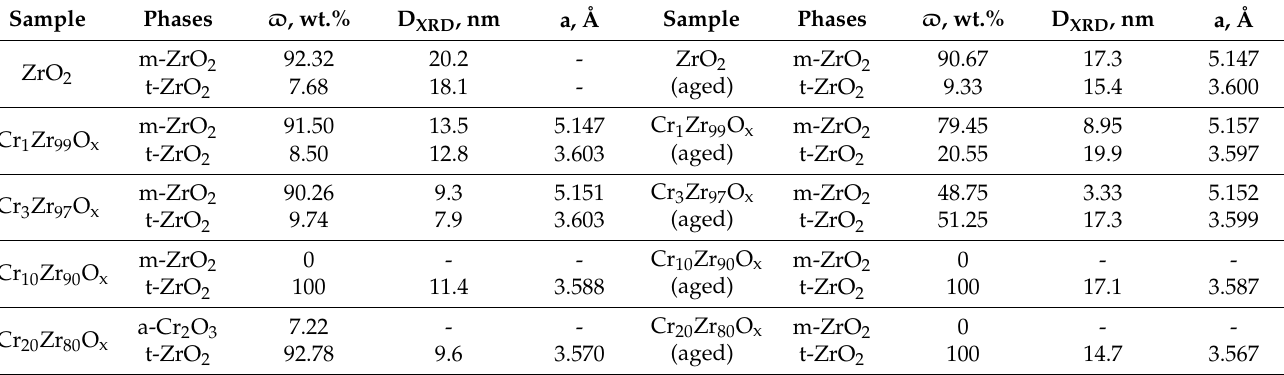
Table 2. The XRD results.